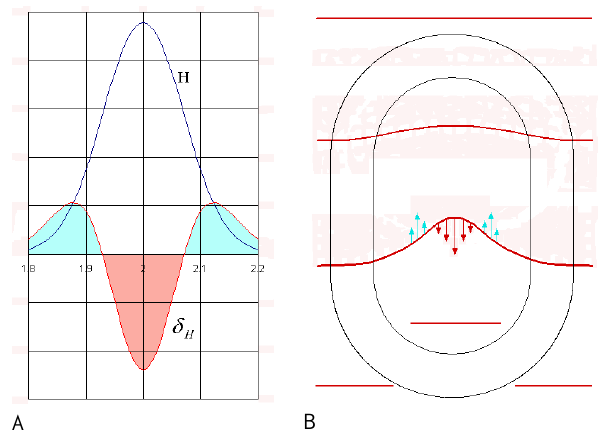
Fig. 11. (A) Evolution of the diffraction parameter δ H with the Fig. 13: A . Evolution of the diffraction parameter  with the wave height graph for the wave height graph for the section located at 5m from the wave H generator, (B) Influence of the diffraction parameter δ H on the crests